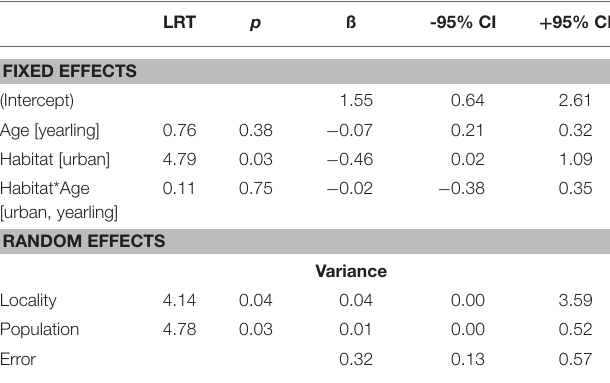
TABLE 4 | Statistical summary of the analysis of distress calling rate between rural and urban habitats. LRT